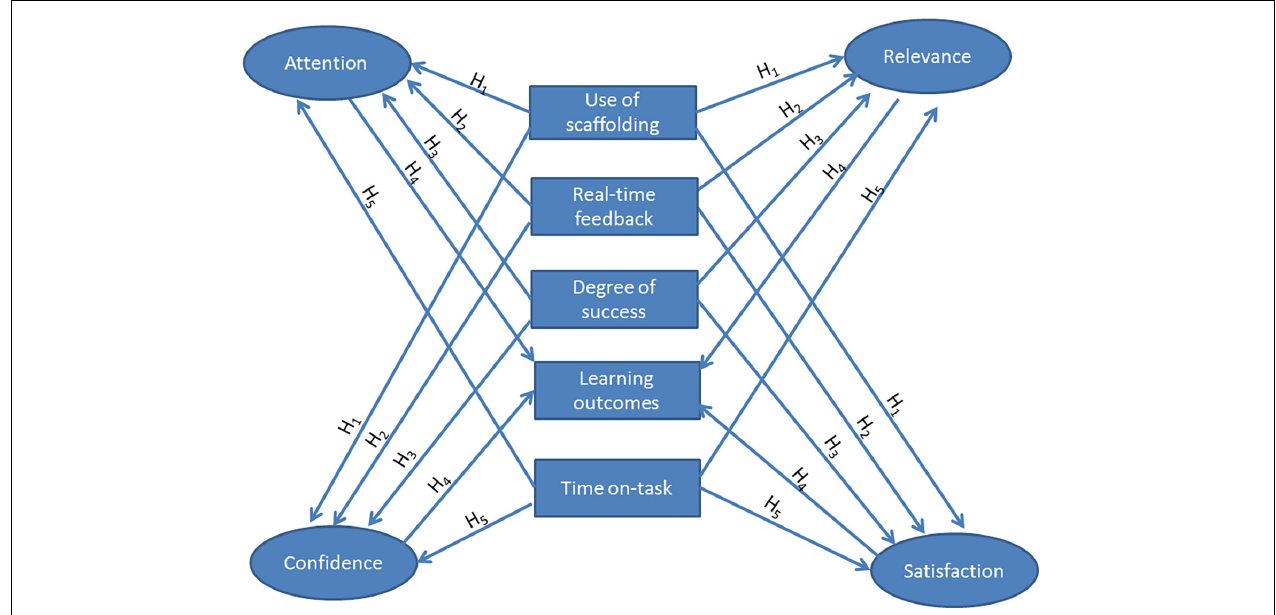
FIGURE 2 | Research model for hypotheses H1, H2, H3, H4, and